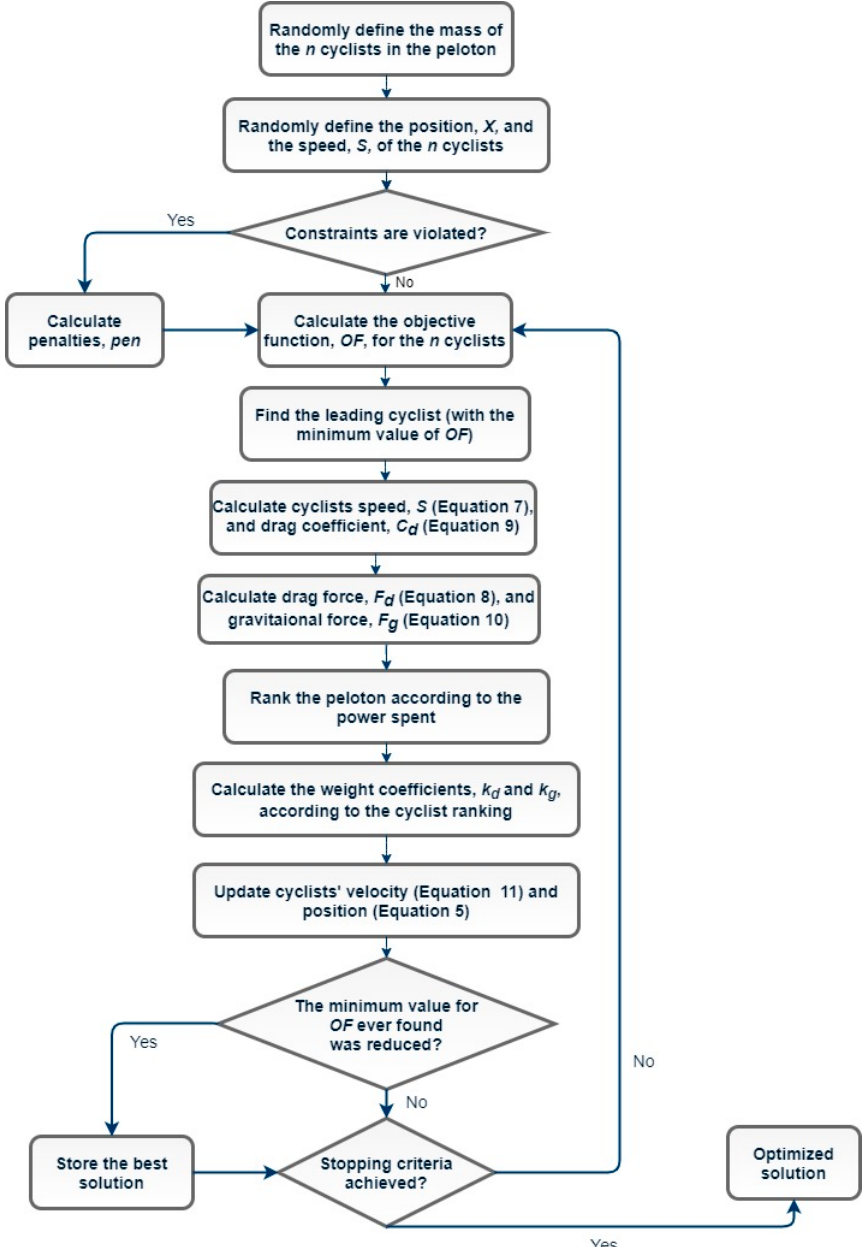
Figure 1. Flowchart of the Grand Tour Algorithm.